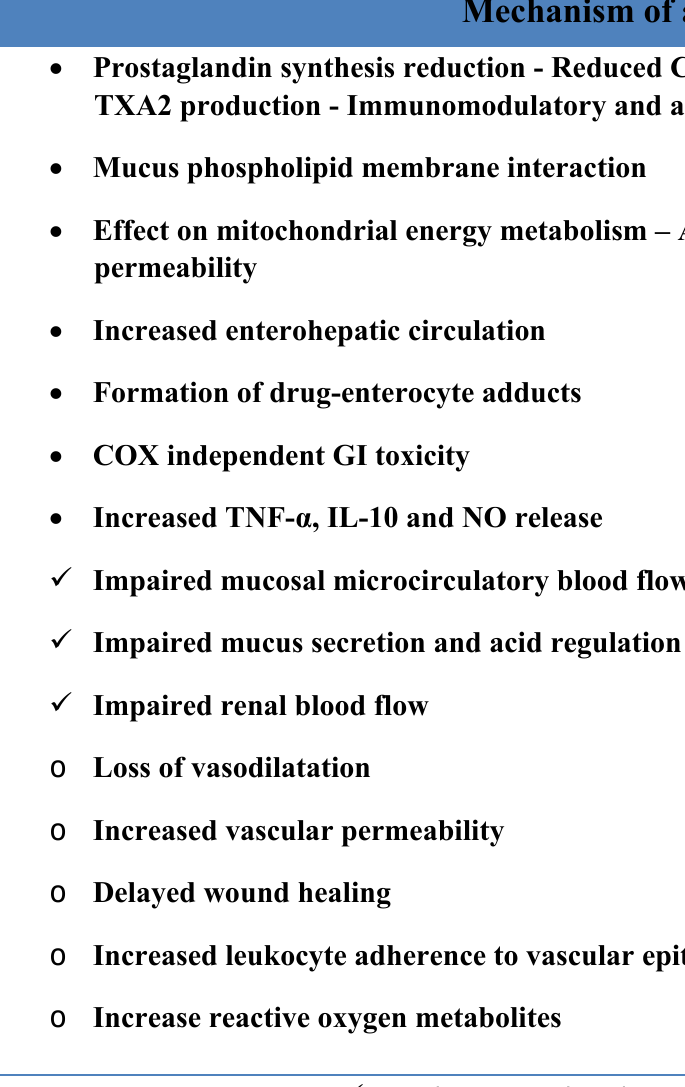
Table 1. Possible molecular mechanisms of NSAIDS induced IBD exacerbations [4]. Adapted with kind permission from Springer Science+Business